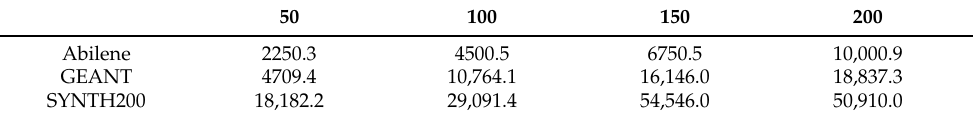
Figure 6. Simulation topologies. Table 3. Average number of flows according to topology and hosts.